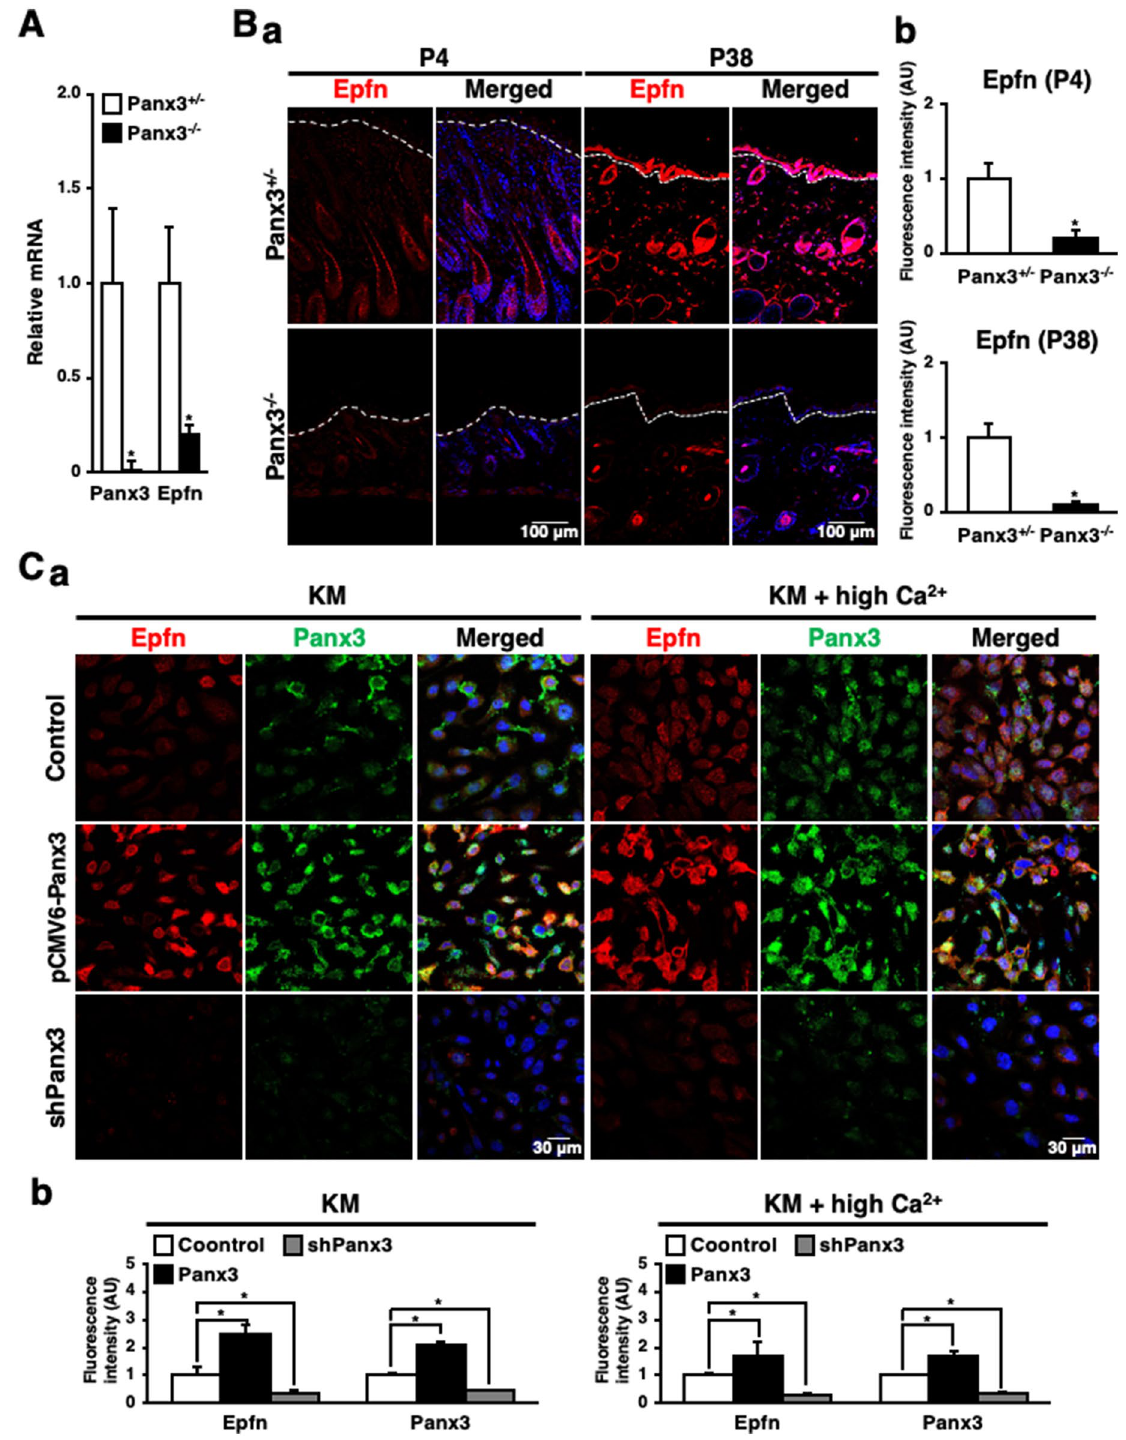
Figure 5. Panx3 regulates Epfn expression during keratinocyte differentiation. ( A ) qPCR for Panx3 and Epfn using total RNA prepared from skin of 6 weeks old Panx3 +/− and Panx3 −/− mice. Results represent the mean ± SD; N = 3. * p < 0.01. ( B ) Immunostaining of Epfn (red) in Panx3 +/− and Panx3 −/− mice skin of P4 and P38. The nuclei were counterstained with DAPI (blue in merged) ( a ). Relative fluorescence intensity comparison of images were analyzed ( b ). * p < 0.01. Error bars represent the mean ± SD; N = 3. ( C ) Immunostaining for Panx3 (green) and Epfn (red) in pCMV6-Panx3 or shPanx3 transiently transfected HaCaT cells cultured in normal medium (KM) and differentiation medium containing 1.4 mM Ca 2+ (KM + high Ca 2+ ). The nuclei were counterstained with DAPI (blue in merged) ( a ). Relative fluorescence intensity comparison of images were analyzed ( b ). * p < 0.01. Error bars represent the mean ± SD; N =